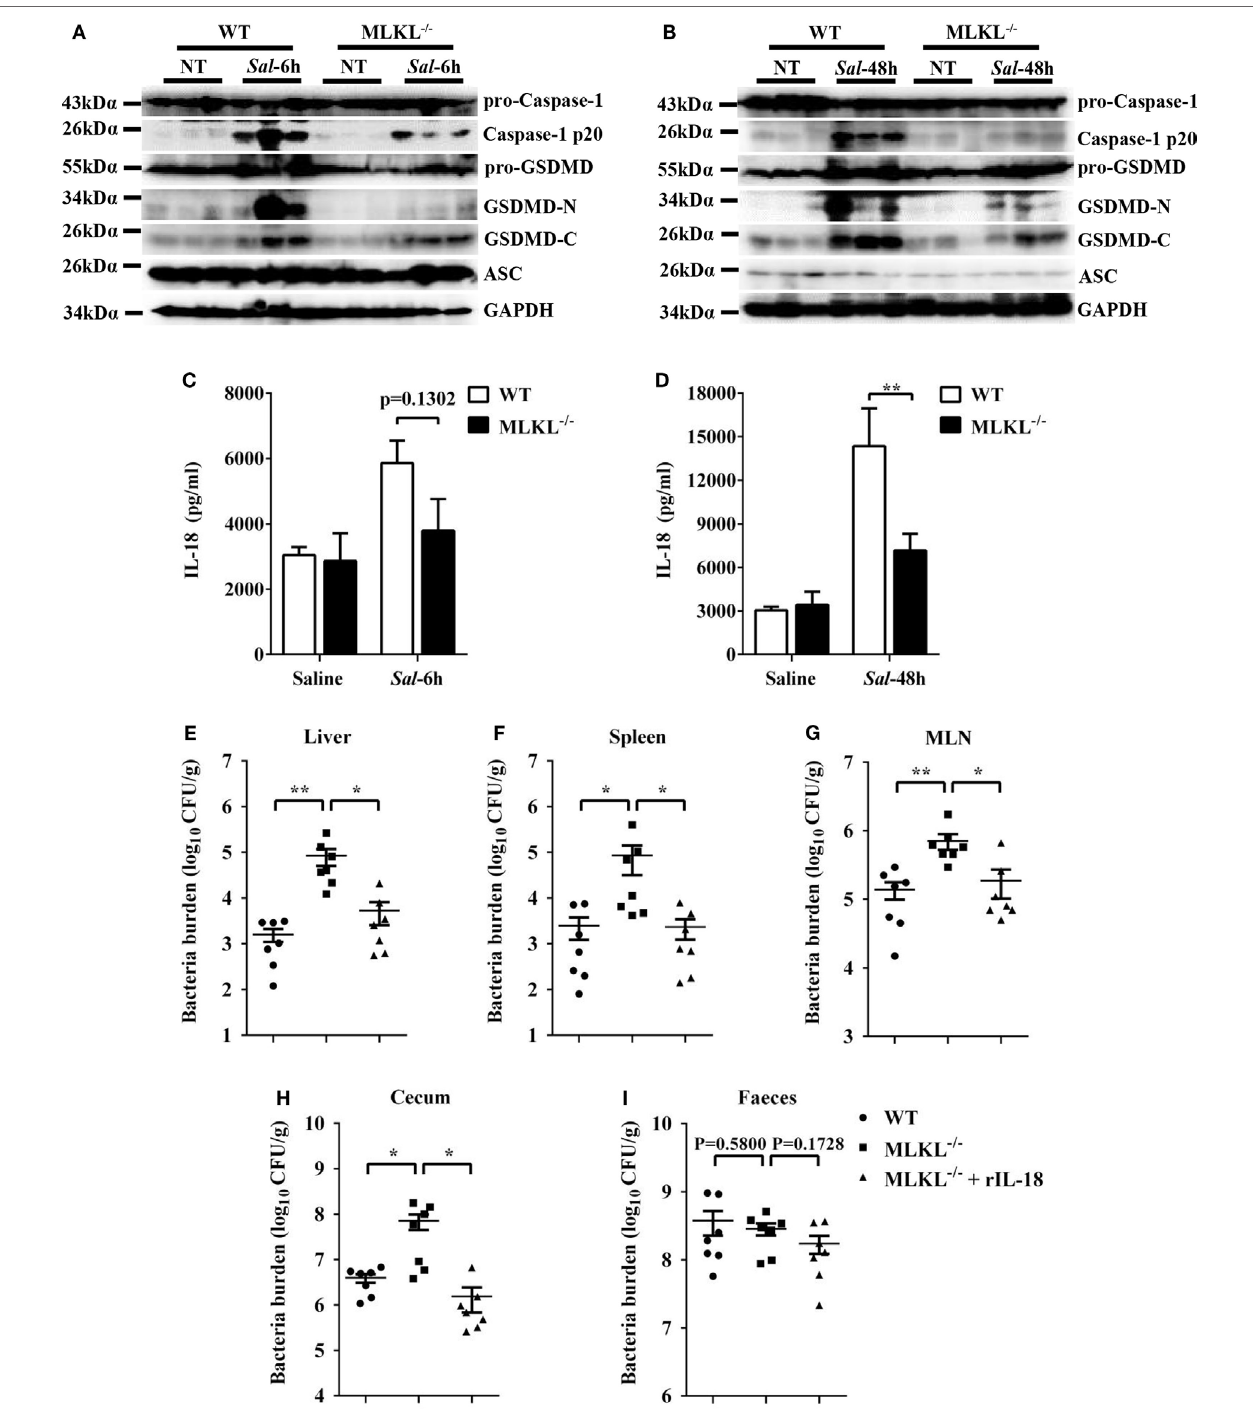
FigUre 7 | Inflammasome signaling downstream of MLKL confers protection against Salmonella infection. Streptomycin-pretreated WT and MLKL − / − mice were orally infected with Salmonella (5 × 10 7 CFU, n = 10 each group) for 6 or 48 h. (a,B) The cecum tissue lysate was analyzed for caspase-1, GSDMD, and ASC by western blotting. GAPDH was used as a loading control. (c,D) The homogenate supernatant of the cecum tissue was analyzed for the presence of IL-18 protein using ELISA. For one group of MLKL − / − mice, 1.0 µg recombinant IL-18 was injected intraperitoneally daily starting the day prior to Salmonella challenge (5 × 10 7 CFU, n = 7 each group, at 48 h p.i.). Bacterial burdens in the liver (e) , spleen (F) , MLN (g) , cecum (h) , and feces (i) were determined, respectively. All data are shown as mean ± SEM. Student’s t -test was performed. Statistical significance is indicated by * p < 0.05, ** p <